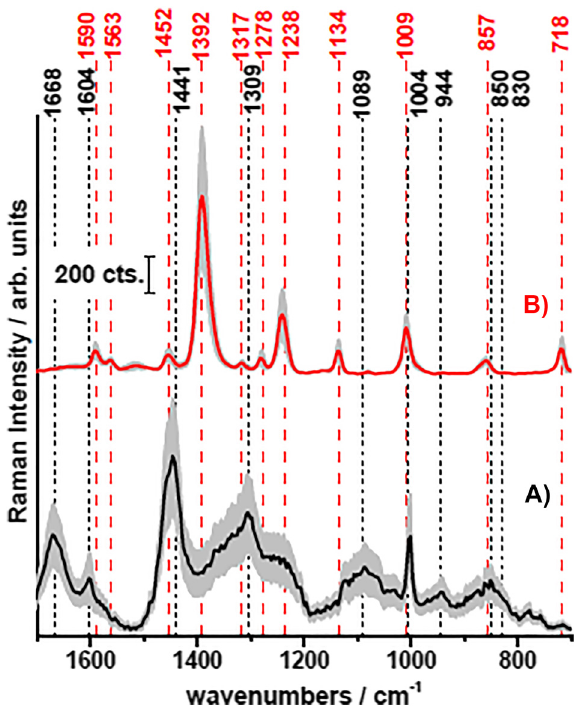
Figure 16: (A) Mean of Raman spectra of Mycobacterium tuberculosis Beijing (ID 8304/09); (B) Mean of surface enhanced Raman scattering (SERS) spectra of M. tb Beijing (ID 8304/09); light gray: Standard deviations. Contributions from all parts of the bacterial cells can be found in the Raman spectra, while the SERS spectra of the disrupted bacterial cells are strongly dominated by contributions from mycolic acid. Reprinted with permission from [75], Copyright (2016) American Chemical Society.